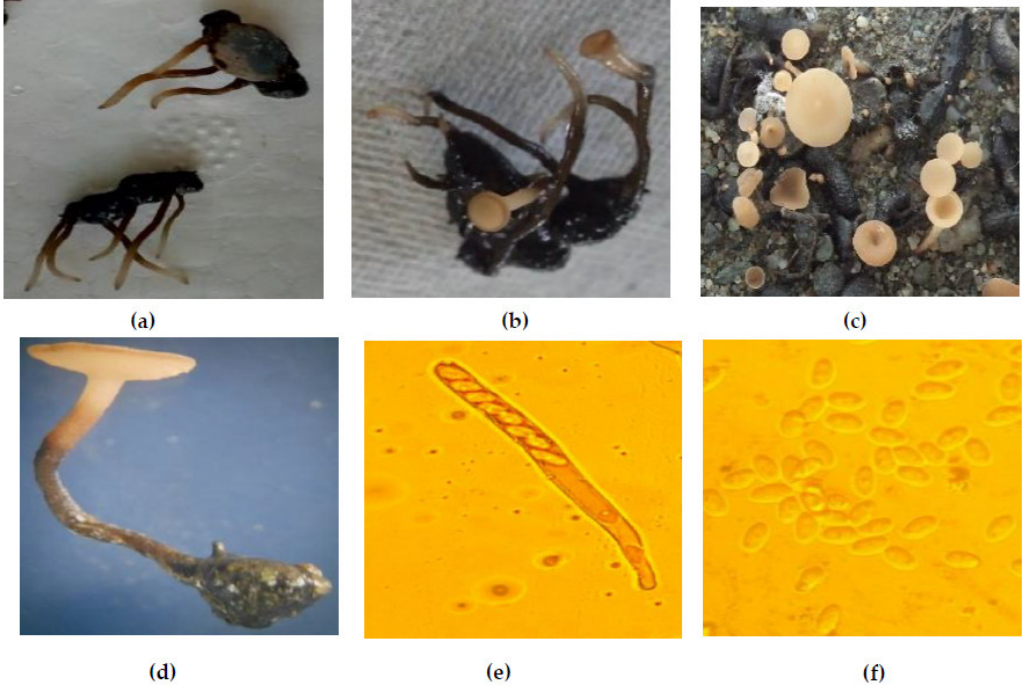
Figure 8. Carpogenic germination of sclerotia of S. sclerotiorum isolates from Kashmir. ( a ) Stipe formation; ( b ) developing apothecia; ( c ) overview of apothecia; ( d ) magnified apothecium; ( e ) ascus with ascospores at 100×; ( f ) ascospores at 400×.